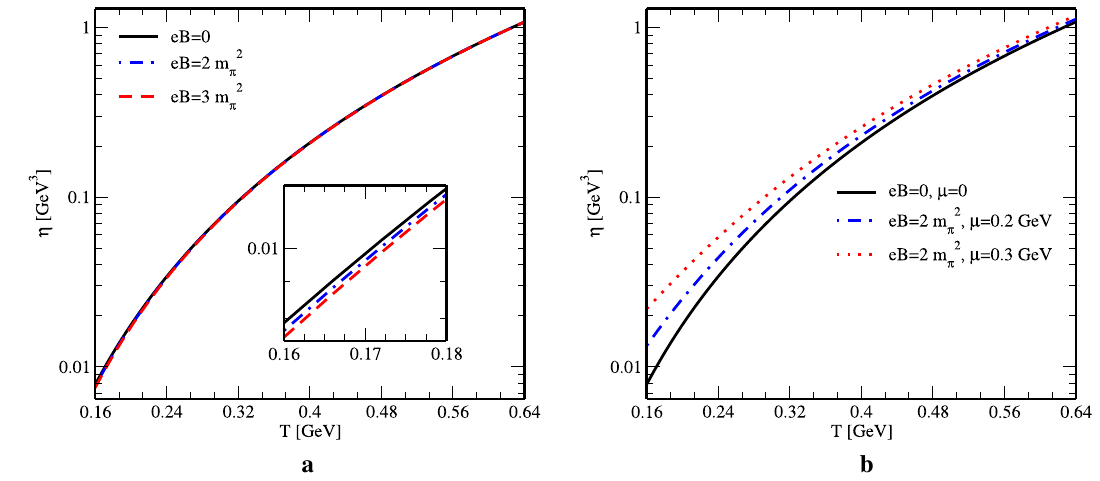
Fig. 1 The variation of the shear viscosity with temperature ( a ) in the presence of weak magnetic field and ( b ) in the presence of finite chemical potential